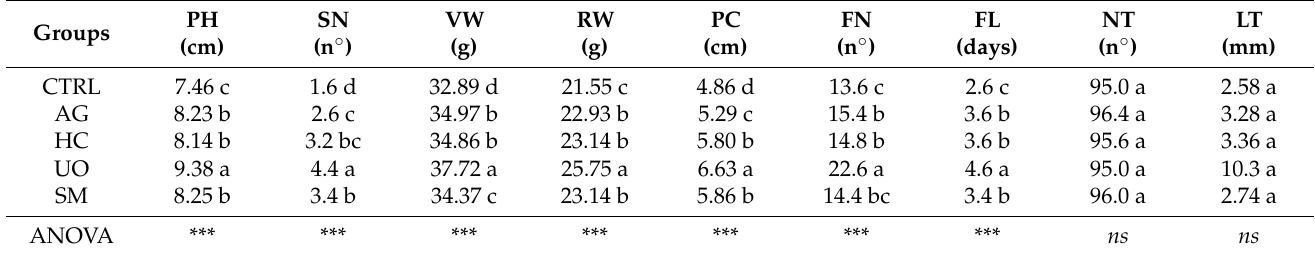
Table 1. Evaluation of liquid seaweed fertiliser on agronomic characters of Mammillaria prolifera .